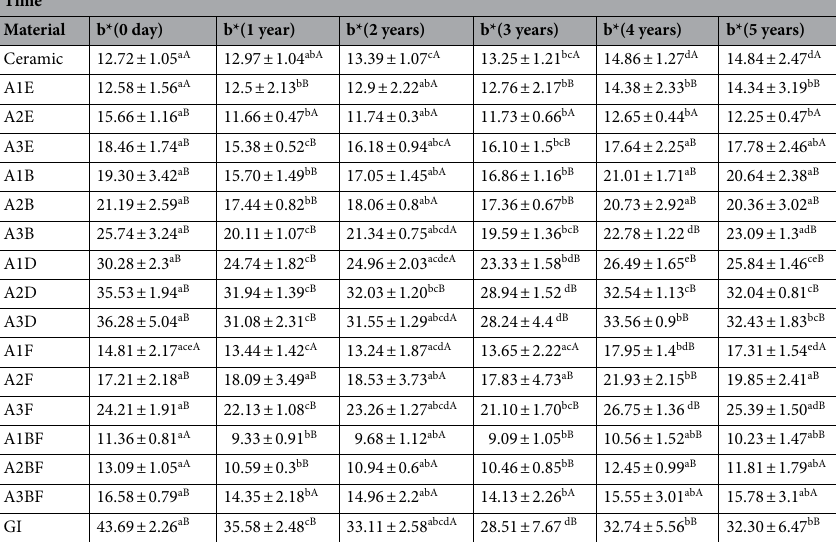
Table 5. Changes in yellowness of the restorative materials and the ceramic across 5 years. Lower case letters indicate significant difference within the row ( p < 0.05). Upper case letters indicate significant difference within the column ( p <